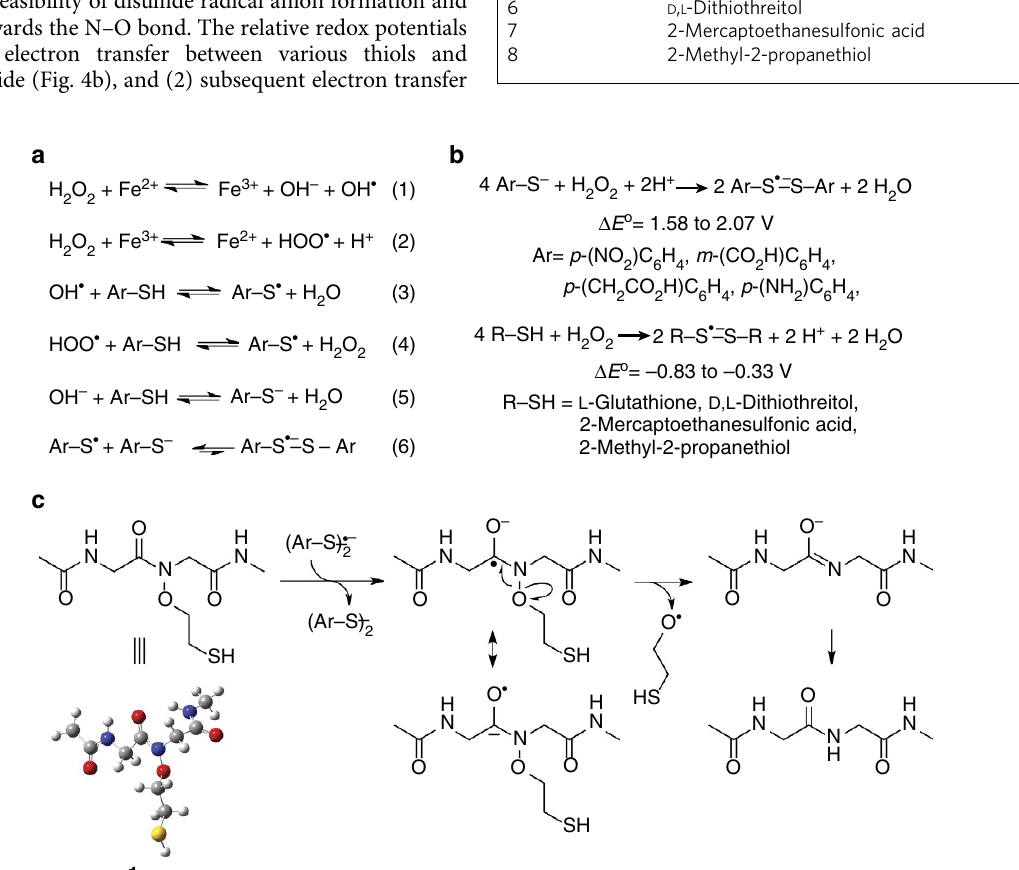
Figure 4 | Formation of disulfide radical anions and their role in N–O bond cleavage. ( a ) Production of aromatic thiyl radicals mediated by trace-metal- catalysed Fenton chemistry (1–4) and their combination with aromatic thiolates to form disulfide radical anions (5–6). ( b ) Net chemical equations for the formation of disulfide radical anions from aromatic thiolates and aliphatic thiols at pH 7.3. The calculated range of standard redox potentials is indicated for compounds from each class of molecules. ( c ) Proposed mechanism for disulfide radical anion-mediated N–O bond cleavage in the model compound 1 .